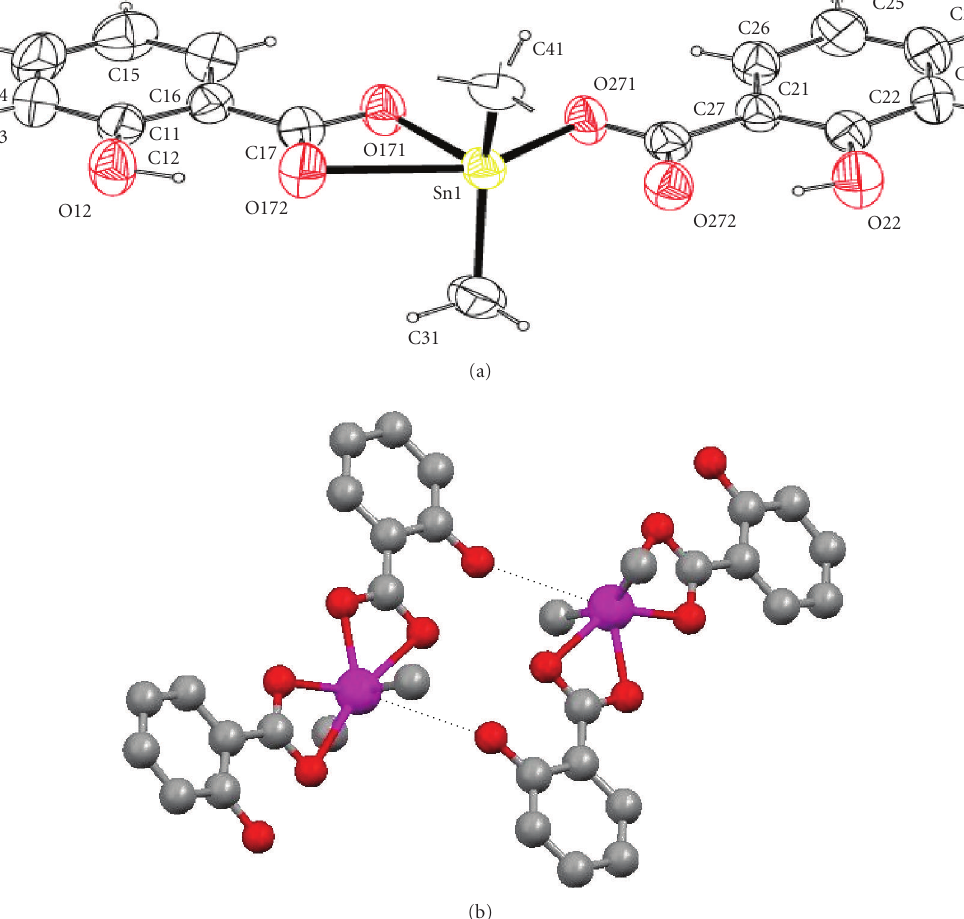
Figure 1: (a) Anisotropic ellipsoid representation of complex 1 . The ellipsoids are drawn at 50% probability level. Selected bond distances ( ˚A) and bond angles (deg.): Sn1-O171 = 2.1069(18), Sn1-O172 = 2.5145(15), Sn1-O271 = 2.1086(15), Sn1-O272 = 2.577, Sn1-C31 = 2.086(3), Sn1-C41 = 2.091(3), O171-Sn1-O172 = 55.56(5), O172-Sn1-O272 = 83.39(6), and O271-Sn1-O171-C17 = 178.46(14). (b) Strong Sn ··· O bonding interaction leads to the formation of a